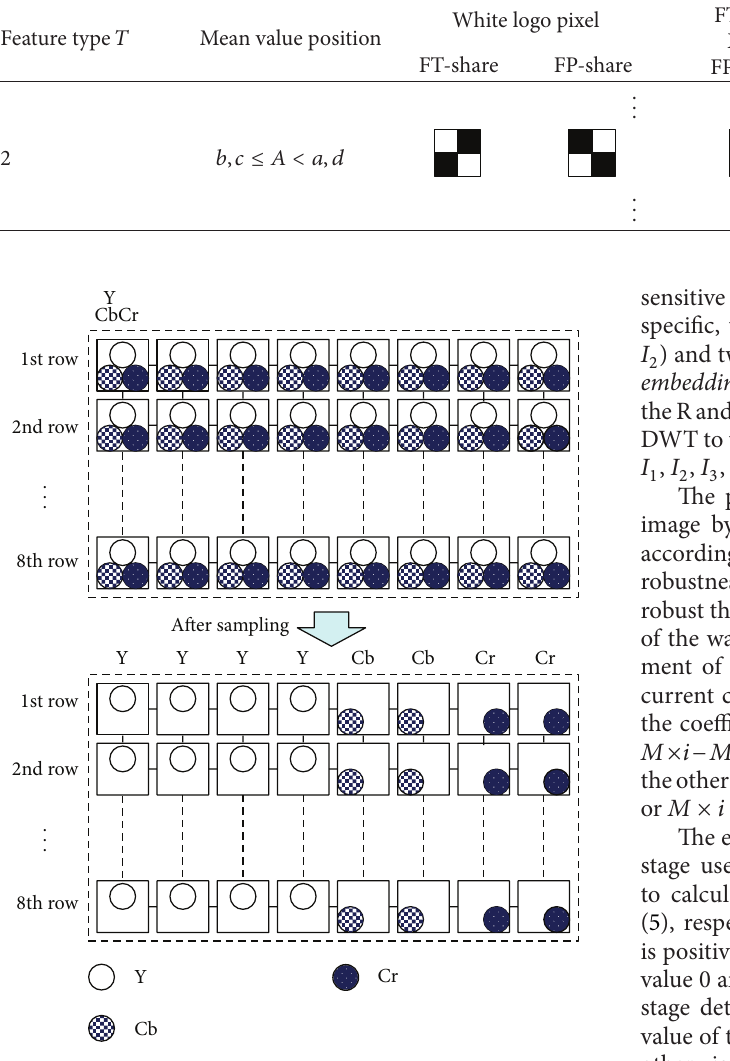
Figure 4: Illustration of sampling